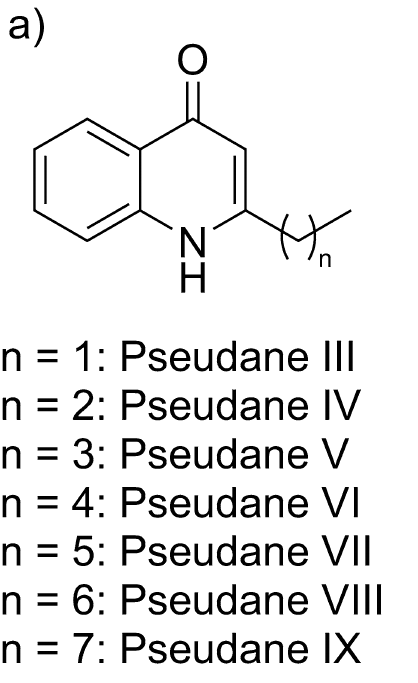
Figure 4. Structures of the major identified secondary metabolites detected from P. galatheae S4498 T . ( a ) Pseudanes III–IX. The structures of pseudane V and pseudane VII were confirmed by NMR spectroscopy, and the identities of the remaining pseudanes were determined by similarities using their MS/MS fragmentation patterns. ( b ) Structure of